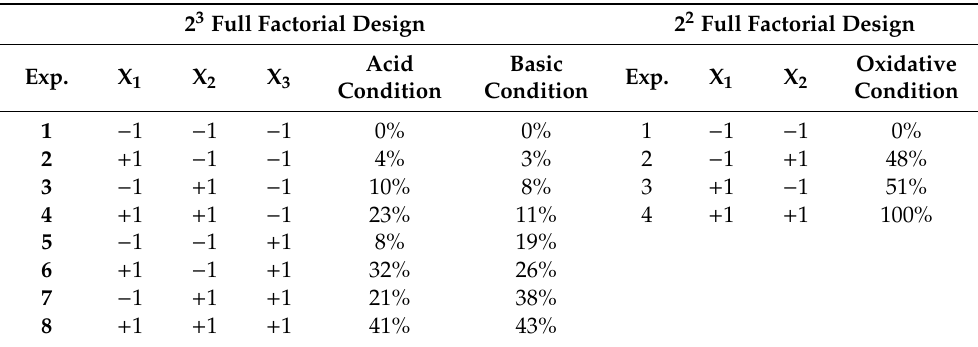
Table 7. Design of experiments with coded values and % of degradation of active pharmaceutical ingredient (API) for acid, basic, and oxidative